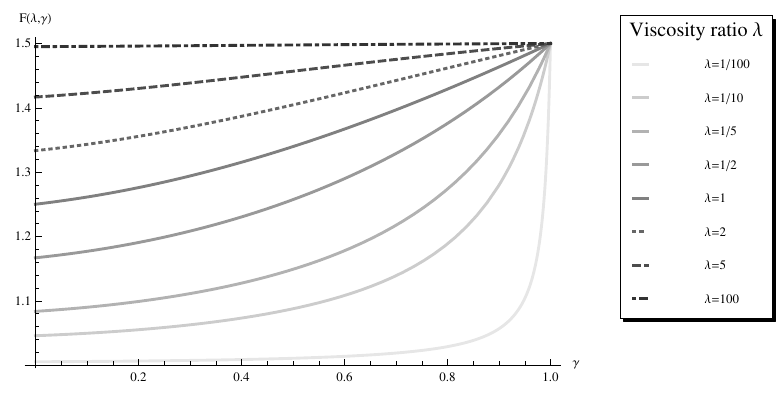
Figure 6. The dimensionless drag force F ( λ , γ ) as a function of γ with fixed values of the viscosity ratio λ . γ 3 is the volume fraction of the